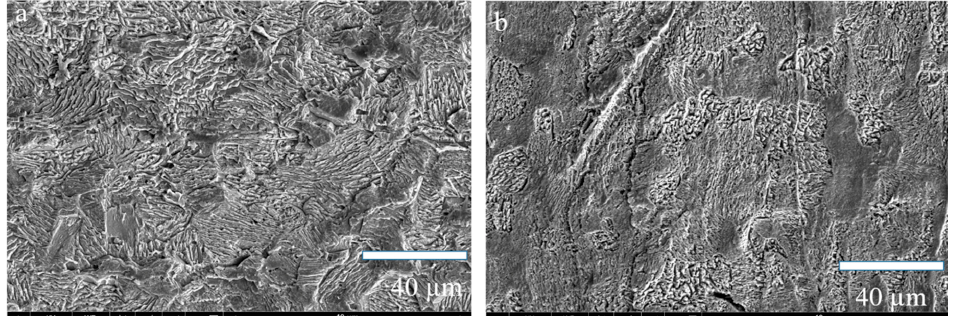
Figure 1. SEM micrographs of the Fe after submersion in 1.0 mol/L ( a ) HCl and 75 mg/L lignin-based quaternary ammonium material (lignin-DMC) + 1.0 mol/L HCl ( b ).